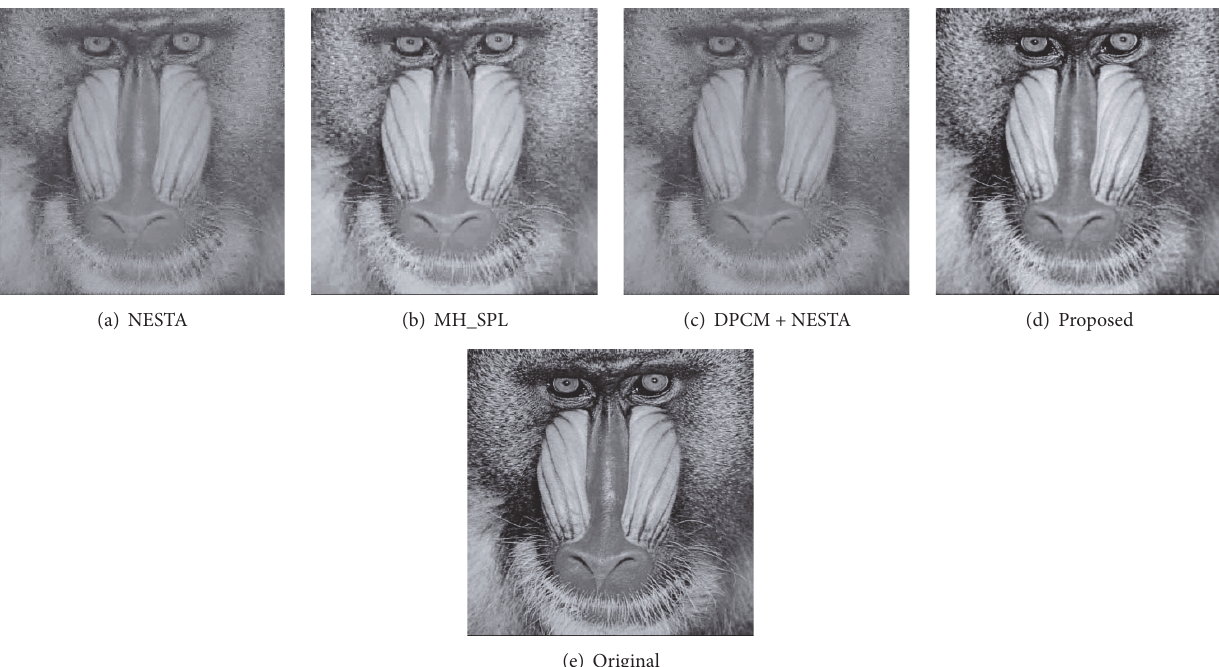
Figure 7: Comparison of visual qualities of Mandrill reconstructed by different methods when the sampling rate 𝑆 is